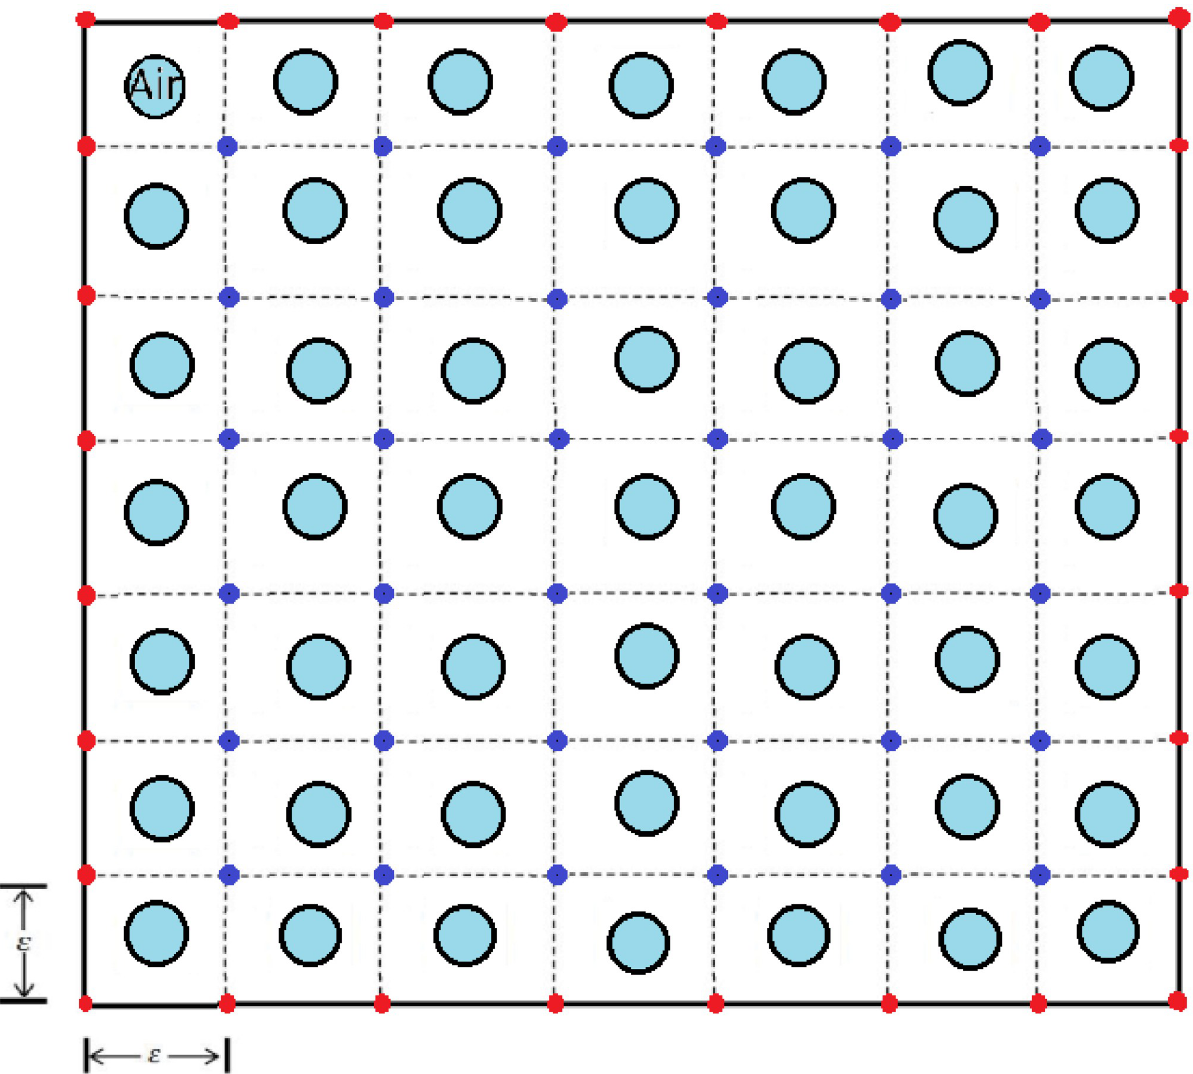
Fig 2. Lung geometry without damage area. Lung geometry consists of squares arranged with smaller circles in the center that show the alveolar air space. Nodes of discretization are indicated by red and blue. The boundary points are shown in red.